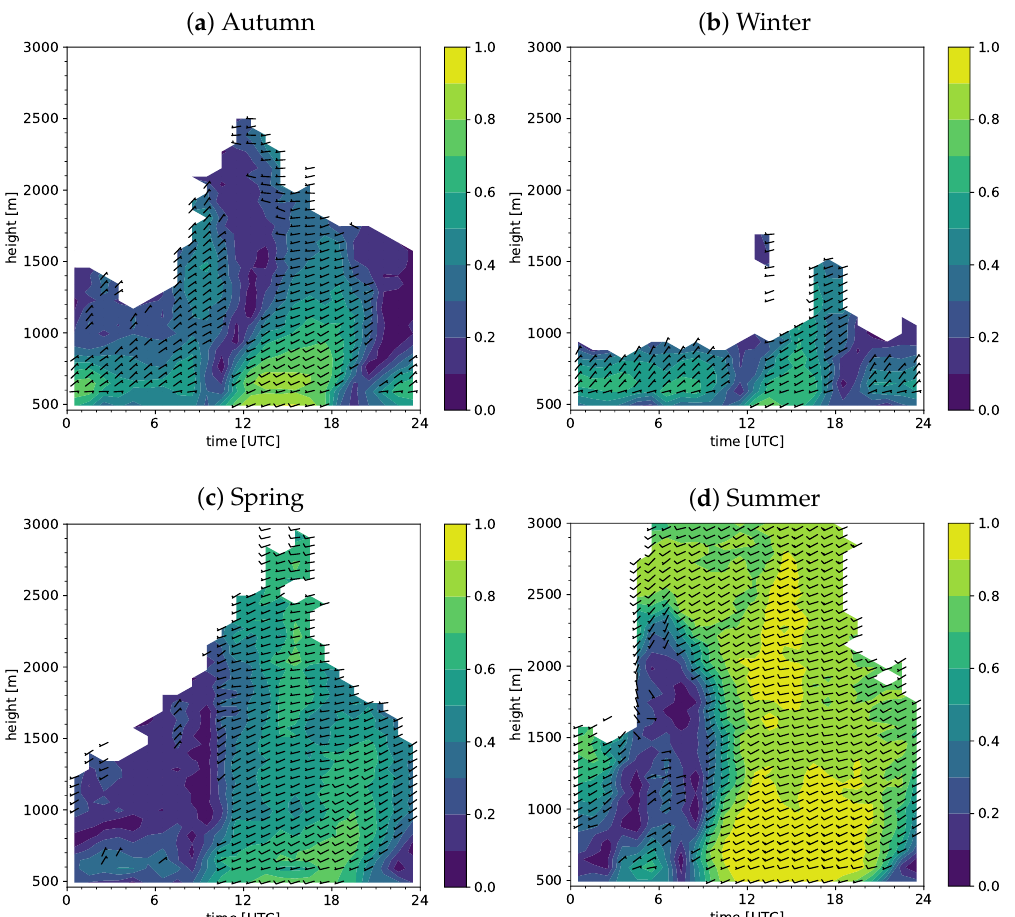
Figure 7. As in Figure 6, but for the directional consistency (color). The barbs denote the absolute wind direction (not relative to valley’s